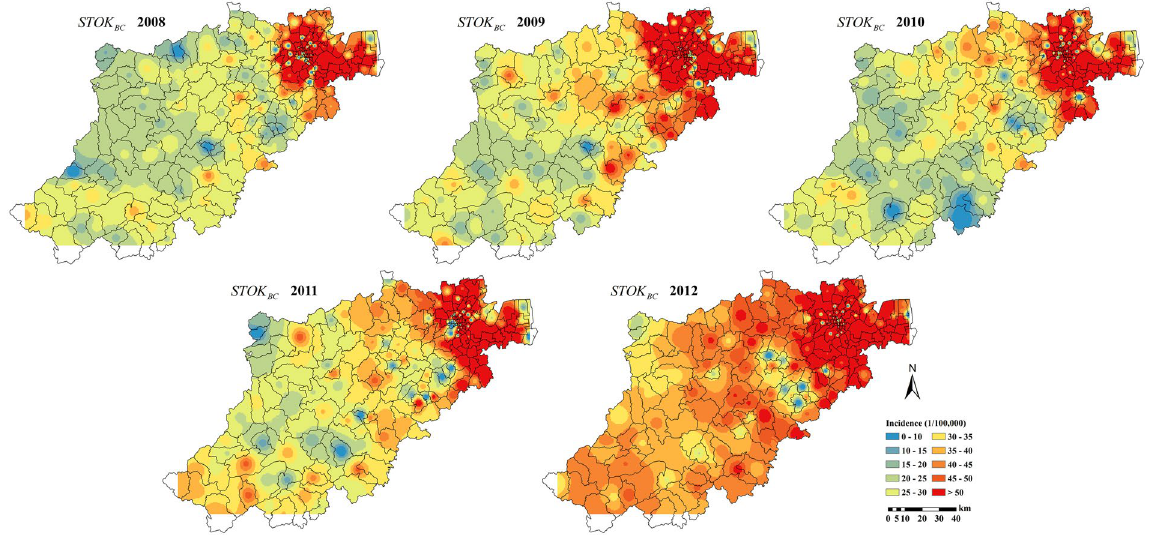
Figure 7. STOK estimation maps of the BC incidence distribution in Hangzhou city during 2008–2012. Maps were generated using ArcGIS 9.3. URL link: http://desktop.arcgis.com/zh-cn/desktop/.